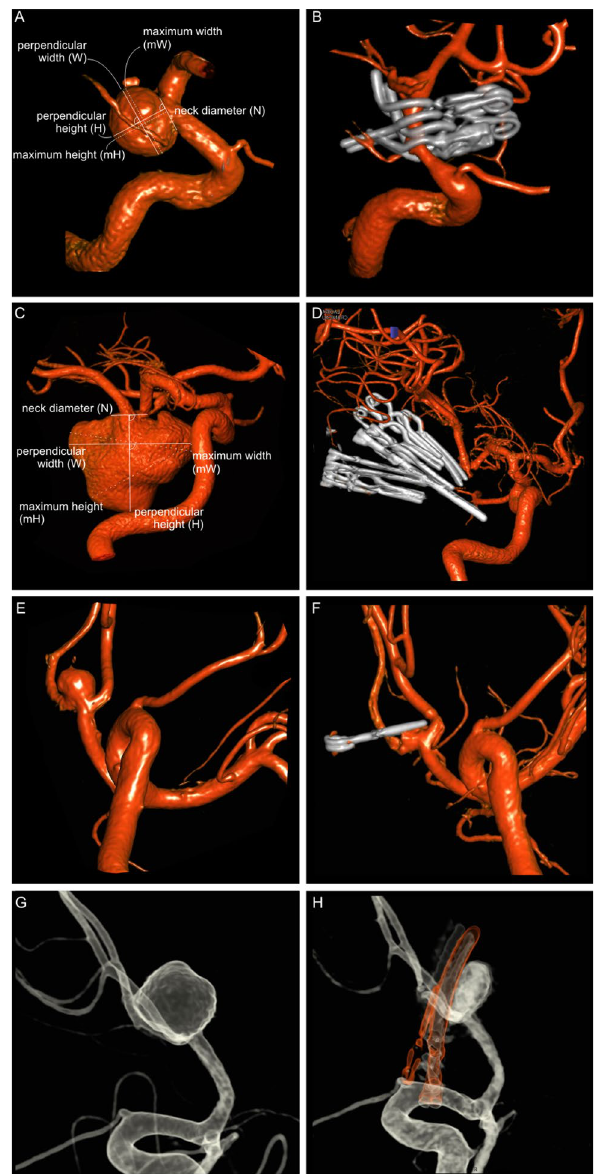
Figure 1. ( A , B ) A case with a saccular perpendicular ICA-Pcomm aneurysm and its complete occlusion by 4 clips. ( C , D ) A case with a nonsaccular non-perpendicular MCA aneurysm and its complete occlusion by 9 clips. ( E , F ) A case with AcommA aneurysm and its neck remnant. ( G , H ) A case with AcommA aneurysm and its aneurysmal remnant. Afterwards, postoperative endovascular treatment of the remnant was performed. ICA interal carotid artery, Pcomm posterior communicating artery, MCA media cerebral artery, AcommA anterior communicans